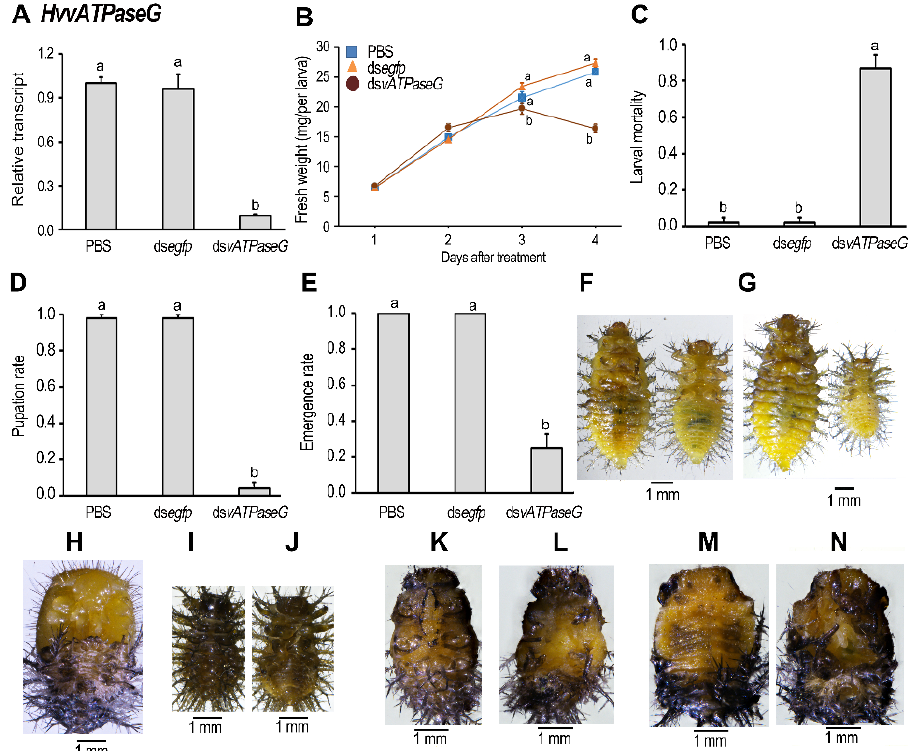
Figure 2. Ingestion of ds vATPaseG by the final instar larvae affects performance in Henosepilachna vigintioctopunctata . The newly-ecdysed final instar larvae had ingested PBS-, ds egfp -, ds vATPaseG - dipped leaves for three days. The expression levels of HvvATPaseG were determined ( A ). Relative transcripts are the ratios of relative copy numbers in treated individuals to PBS-fed controls, which are set as 1. The fresh weights were measured daily after initiation of the experiment ( B ); the larval sizes were shown 3 and 4 days after initiation of the experiment ( F , G ; PBS- vs. ds vATPaseG -fed larvae). The larval mortality, pupation and the emergence rate were recorded during a 3 week trial period ( C – E ). The bars represent values (±SE). Different letters indicate significant difference at p value < 0.05 using analysis of variance with the Tukey-Kramer test. While the CK larvae pupated